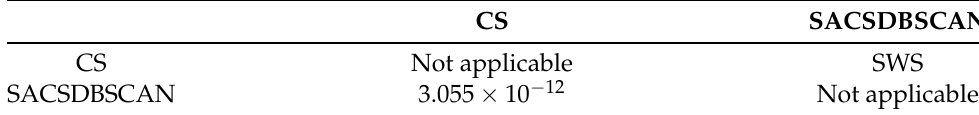
Table 12. p -values for instance A.5.